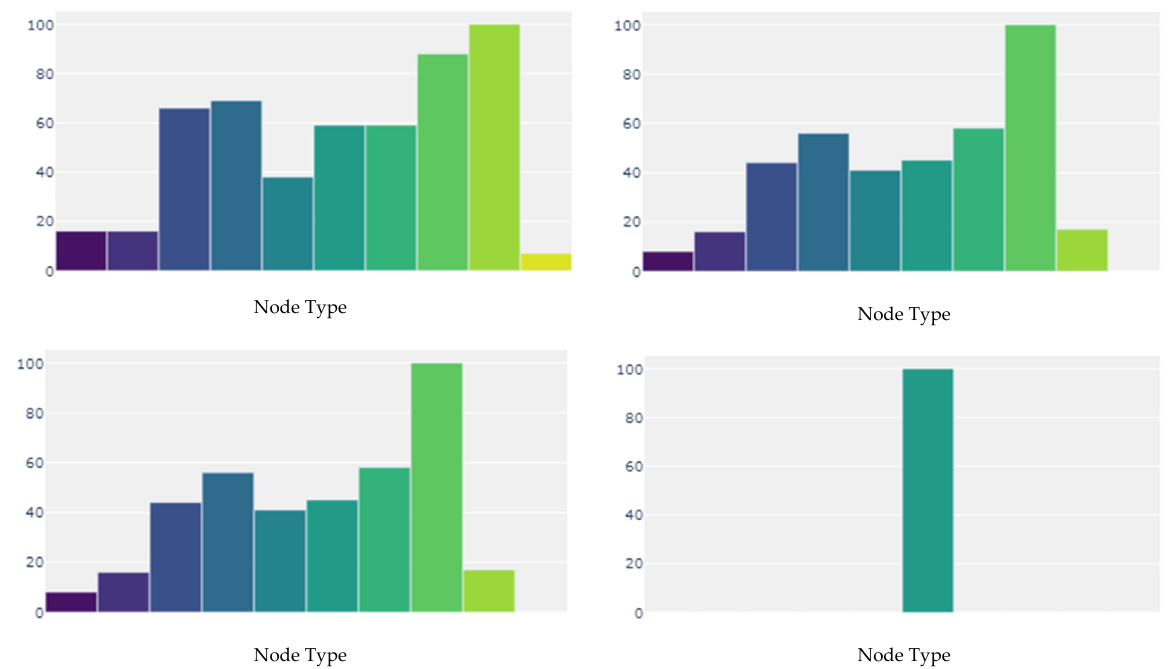
Figure 6. Node distribution diagram, the time sequence is: top left (1), top right (2), bottom left (3), bottom right (4).